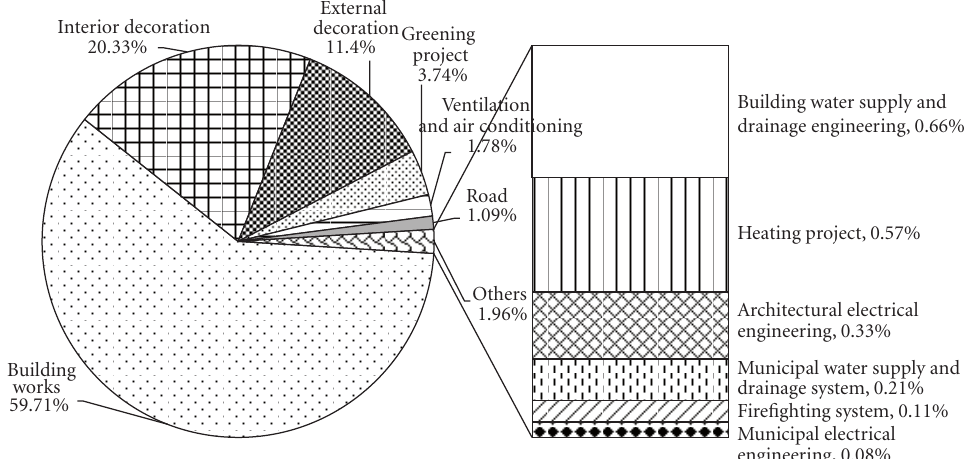
Figure 3: Greenhouse gas emission sources of the construction phase.